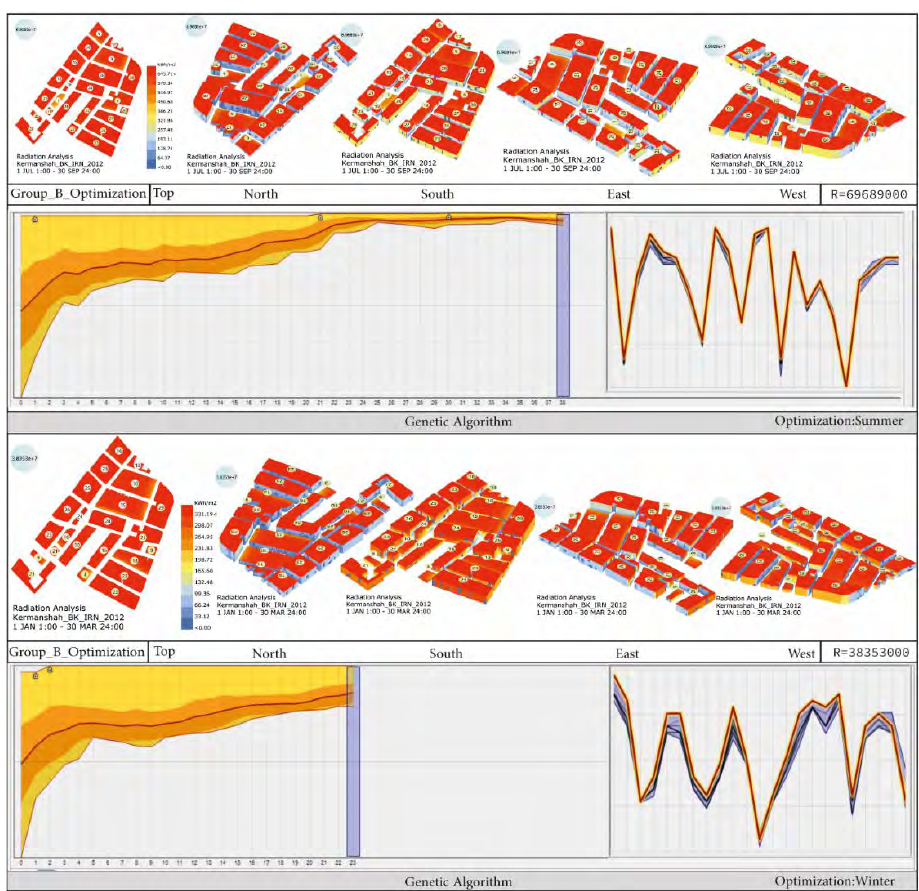
Figure 16- Optimization of urban block variables in winter and summer in group B.